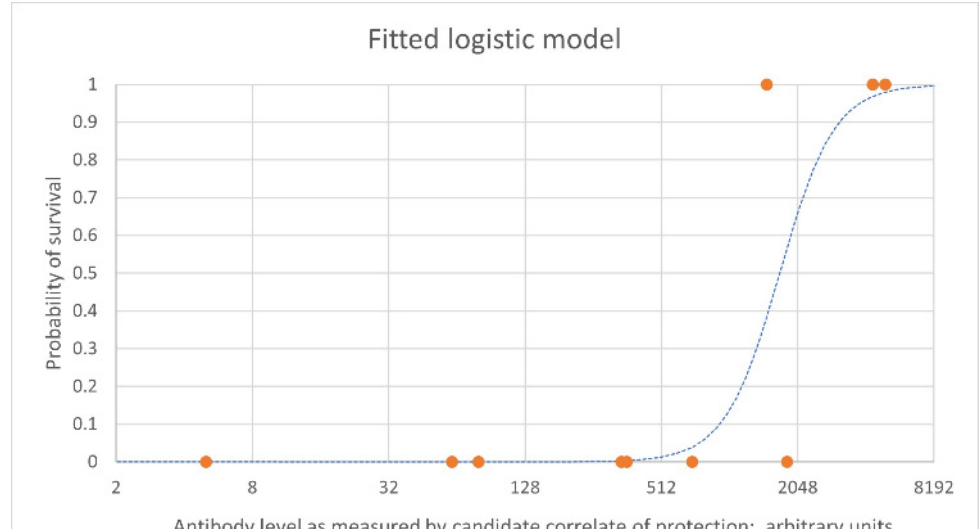
Figure 1. Example logistic regression curve. Example data is used here. The blue dashed line is the estimated logistic model which indicates the probability of survival. The orange points represent individual NHPs. NHPs that survive are shown at 1 on the y axis; NHPs that died are shown at 0 on the y axis.